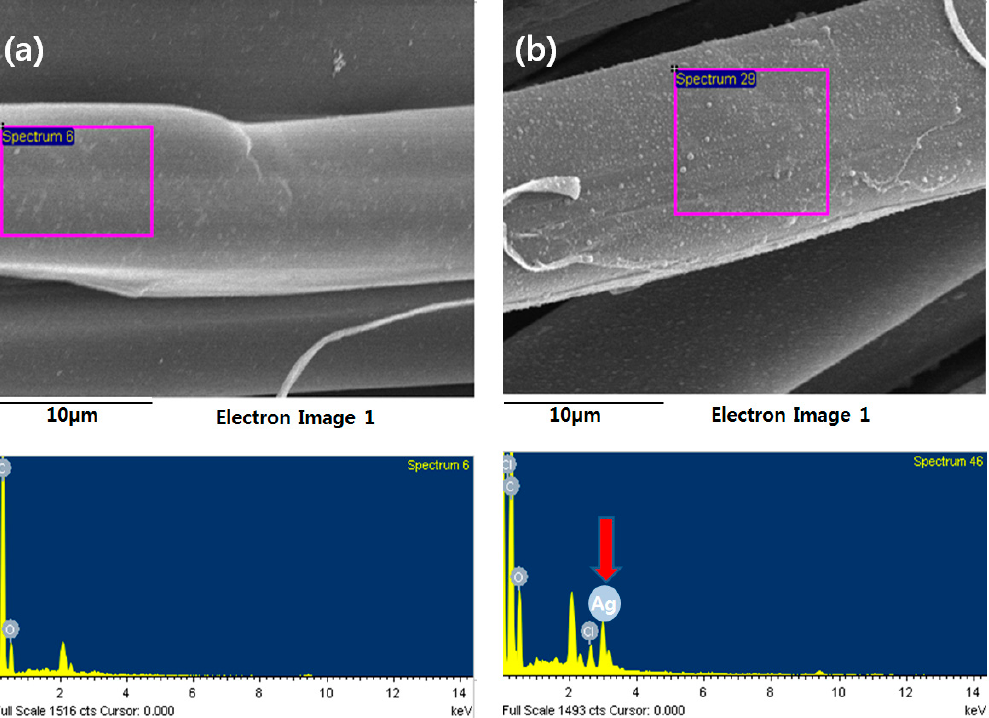
Figure 3. SEM-EDS peak of ( a ) untreated p -aramid and ( b ) treated p -aramid with 30,000 ppm of AgNPs/10 wt % of GTAC.